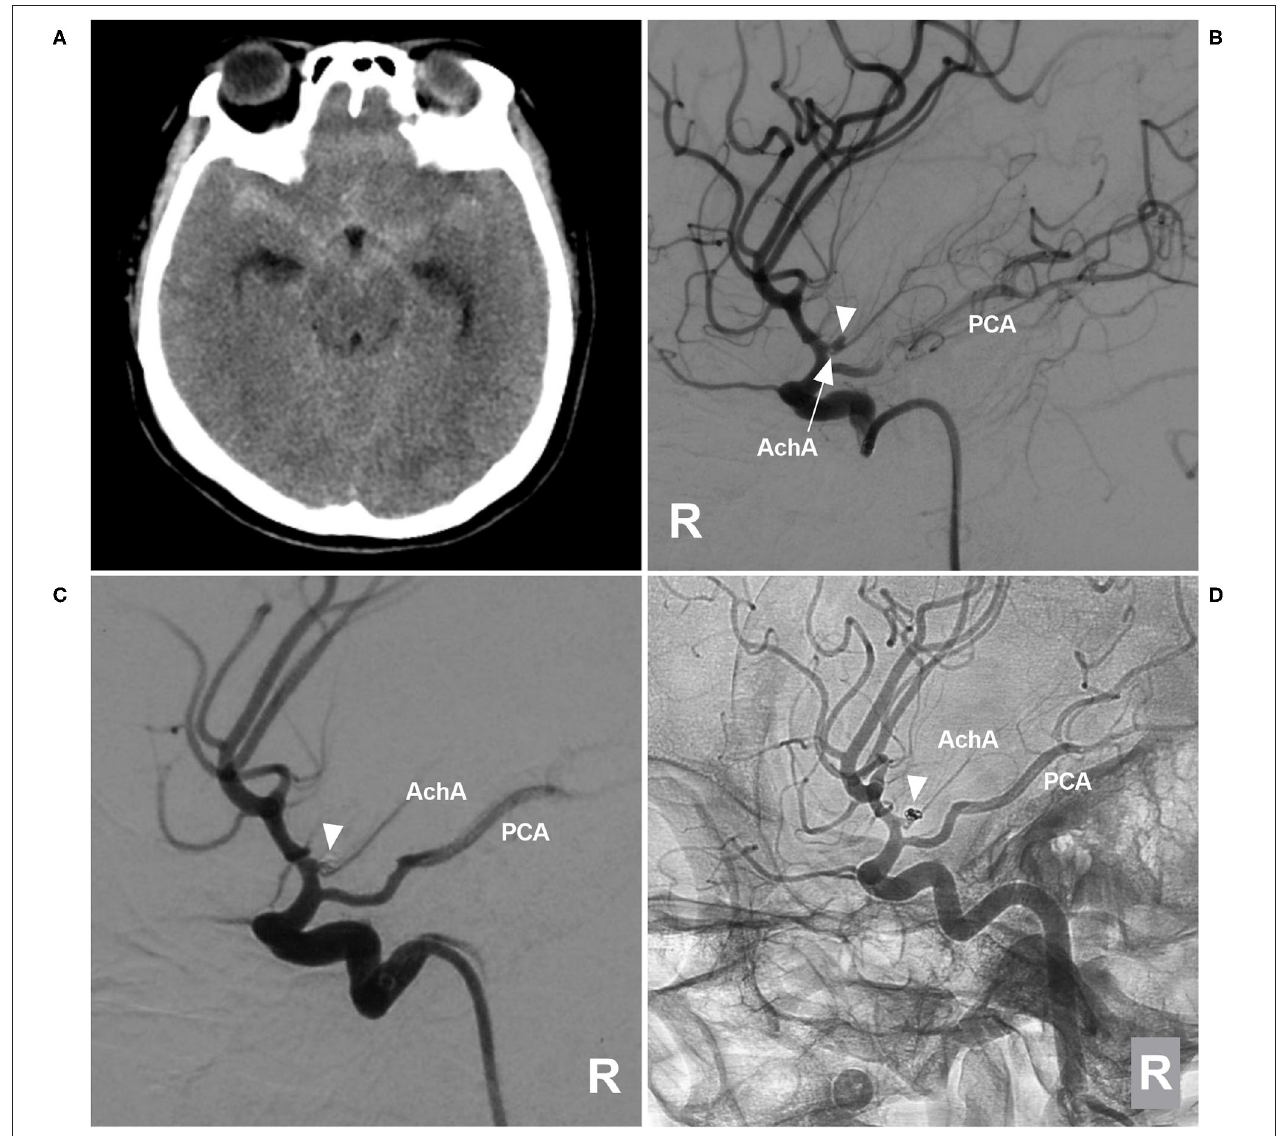
FIGURE 5 | EVT of a type II AchA aneurysm. (A) CT showing subarachnoid hemorrhage. (B) DSA of the right ICA showing a type II AchA aneurysm (triangle); the AchA (arrow) arose from the aneurysm neck, and the PCA was the fetal type. (C) DSA of the right ICA showing that the aneurysm (triangle) was coiled, with MRCC grade I, the AchA was unblocked. (D) Follow-up unsubtracted DSA of the right ICA showing that the aneurysm (triangle) had no recurrence. AchA, anterior choroidal artery; CT, computed tomography; DSA, digital subtraction angiography; EVT, endovascular treatment; ICA, internal carotid artery; MRCC, Modified Raymond-Roy Classification; PCA, posterior cerebral artery; R, right; 3D, three-dimensional. between the ICA and AchA origin was 0–157 degrees (mean, 51.3